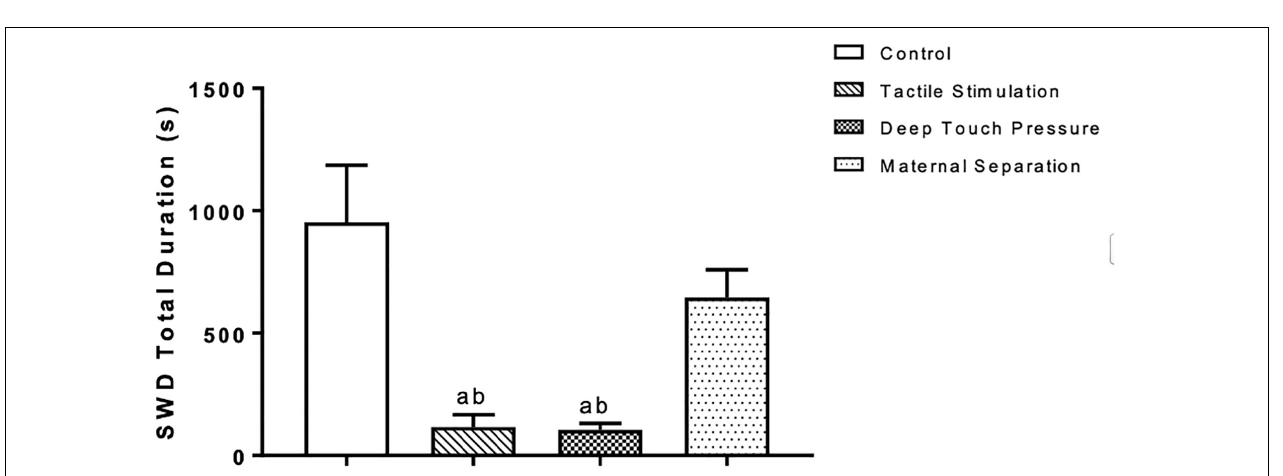
FIGURE 7 | The mean duration (in seconds) of SWD was different between groups. The data are presented as mean ± SEM ( n = 8 per group). Mean SWD duration in TS ( a p < 0.05) and DTP ( d p < 0.001) groups was less compared to control group at the 1st hour. At the 2nd hour of recordings mean duration of SWD was less at DTP group compared to control ( a p < 0.005), MS ( b p < 0.05), and TS ( c p < 0.05) groups. Mean duration of SWD was less in DTP group at 3rd ( a p < 0.001) and 4th ( a p < 0.05) hours compared to control group (two-way ANOVA).